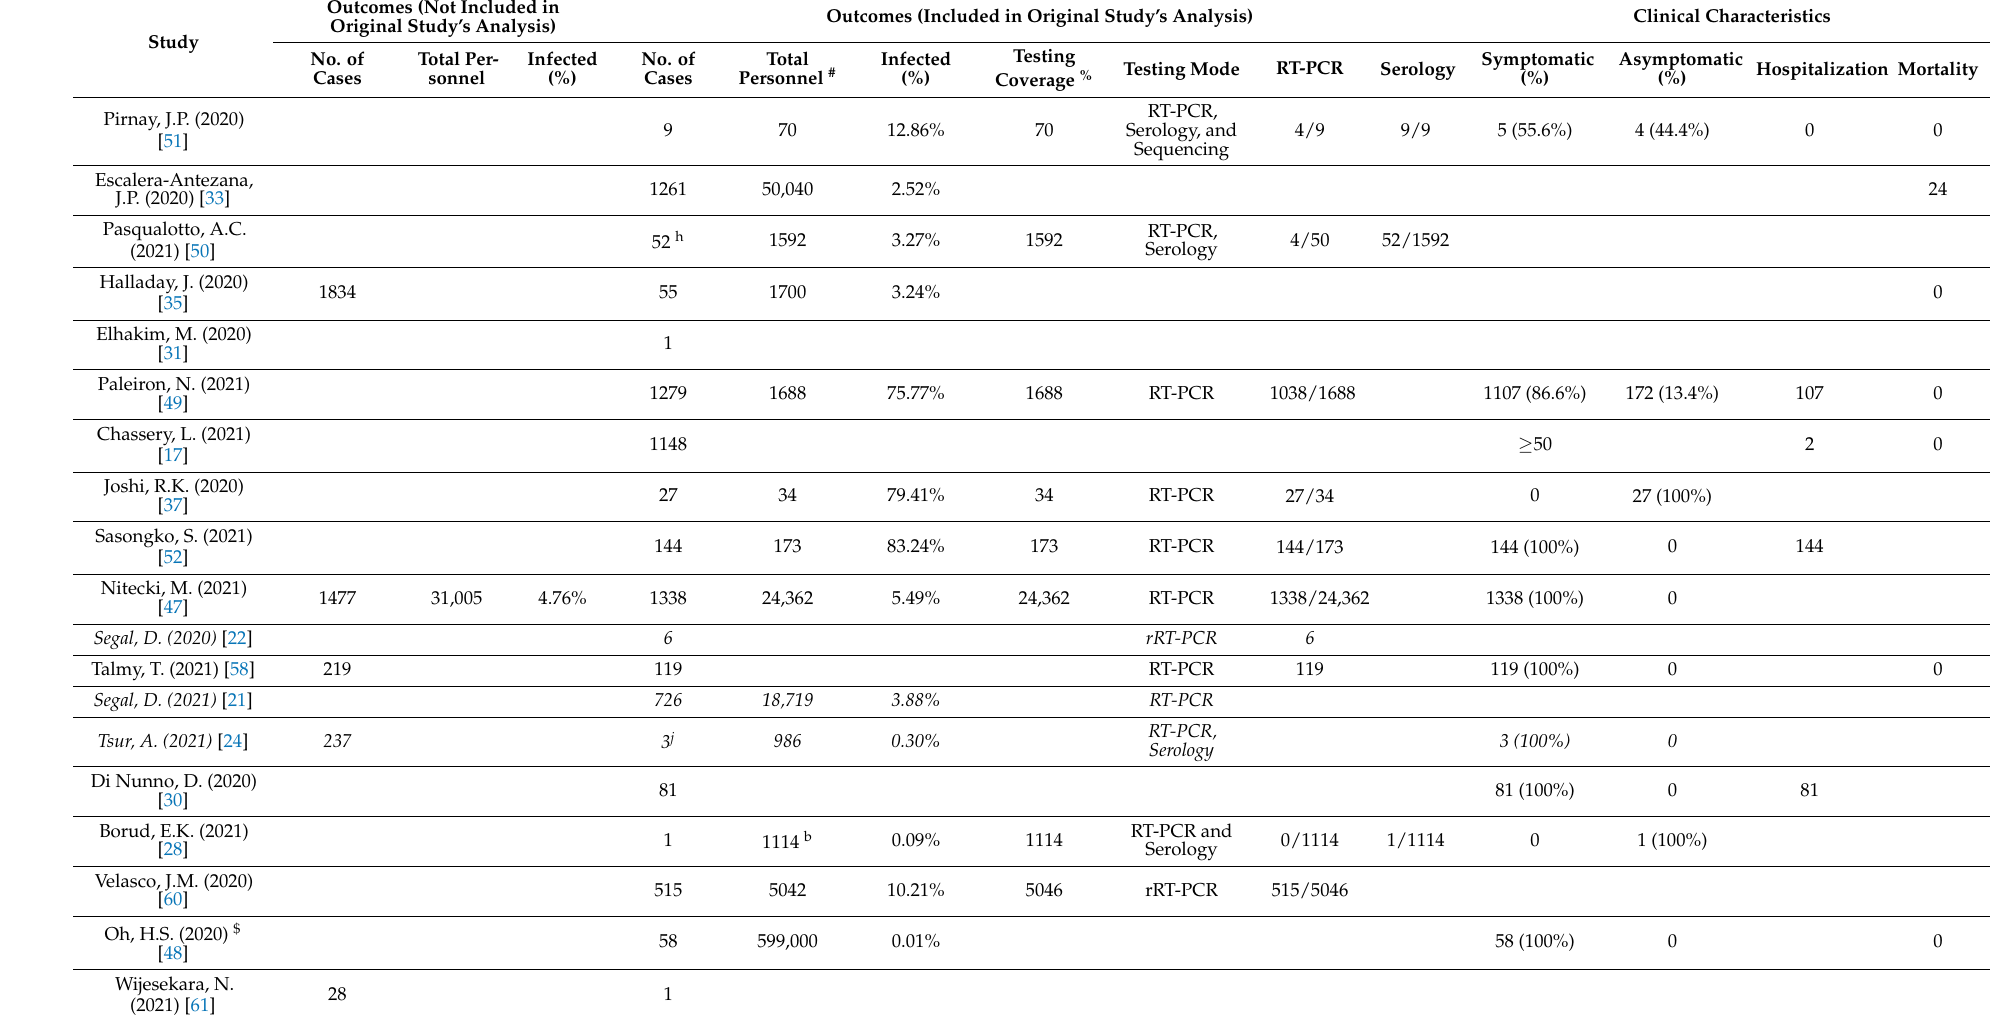
Table 2. COVID-19 outcomes in study